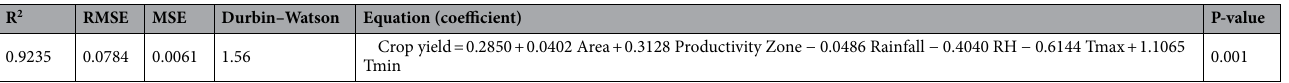
Hidden layer (Hl)